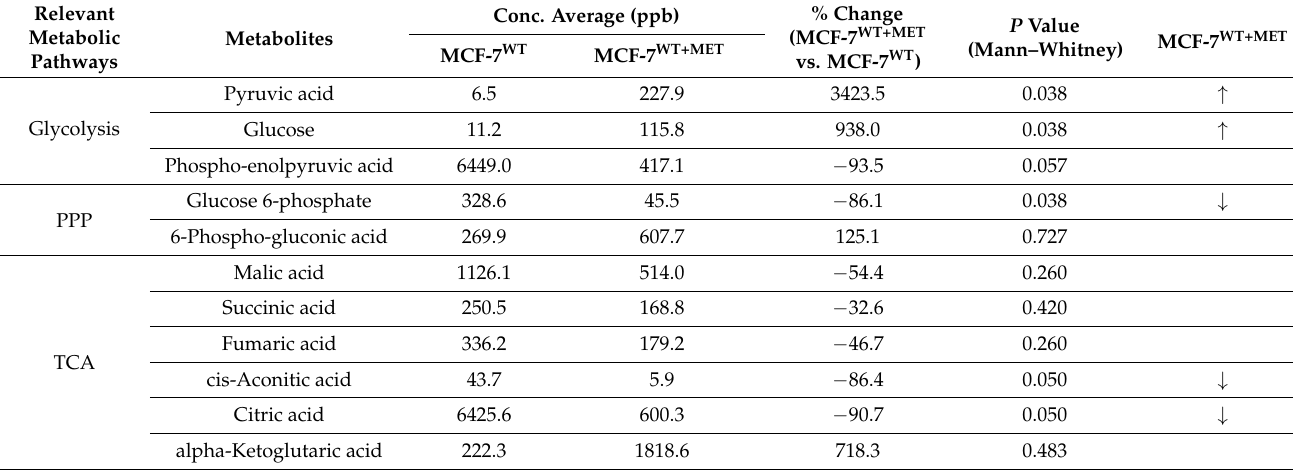
Table 2. Targeted metabolic profiles of some metabolites of glycolysis, pentose phosphate pathway, TCA and urea